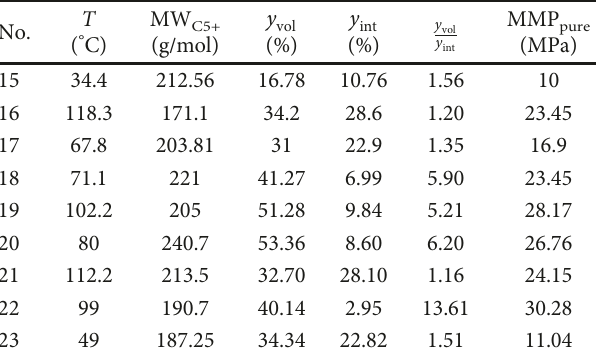
Table 3: Literature reported light oil constituent and MMP